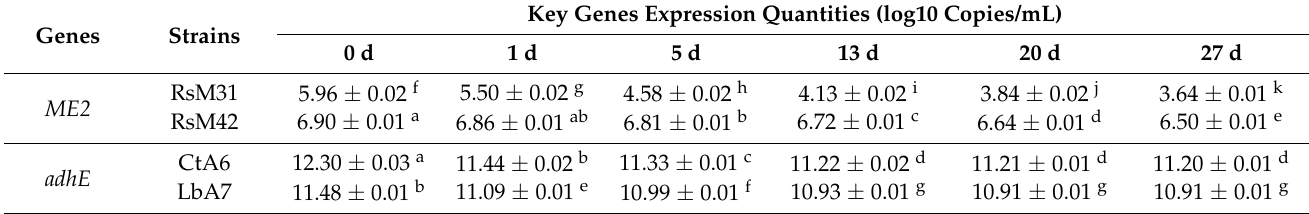
Table 3. Expression quantities of key genes of functional strains in different liquid fermentation